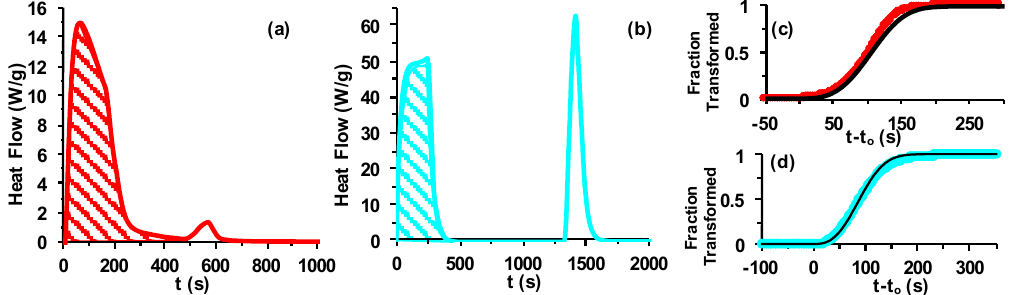
Figure 4. Crystallization by differential scanning calorimetry. Heat flow curves for ( a ) a capillary sample at T iso = 243 K (red) and ( b ) a stainless steel pan sample at T iso = 248 K (cyan). The instrumental quench portion of the signal is shaded. ( c , d ) Normalized, integrated heat-flow of the crystallization reactions, each fit to the KJMA model (black line).